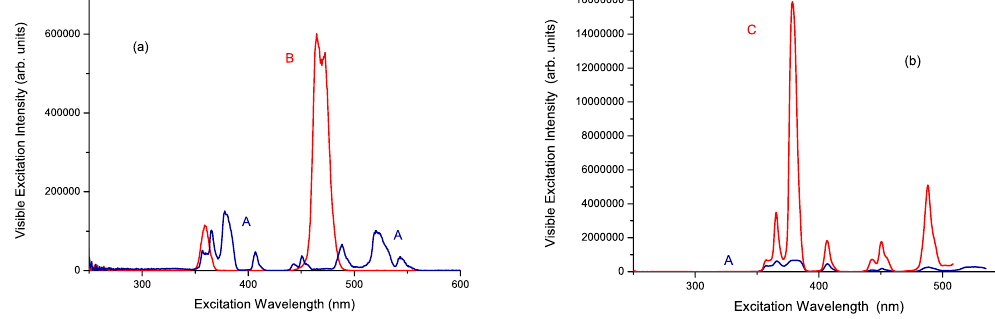
Figure 4. ( a ) The visible excitation spectra of samples (A) Er 3 + (8%)Tm 3 + (0.5%):telluride glass and (B) Tm 3 + (0.5%):telluride glass when monitored at 651 nm for the 4 F 9/2 → 4 I 15/2 luminescence of Er 3 + ions and 1 G 4 → 3 F 4 luminescence of Tm 3 + ions. ( b ) The visible excitation spectra of samples (A) Er 3 + (8%) Tm 3 + (0.5%):telluride glass and (C) Er 3 + (0.5%):telluride glass when monitored at 556 nm for the 4 S 3/2 → 4 I 15/2 luminescence of the Er 3 + ions.